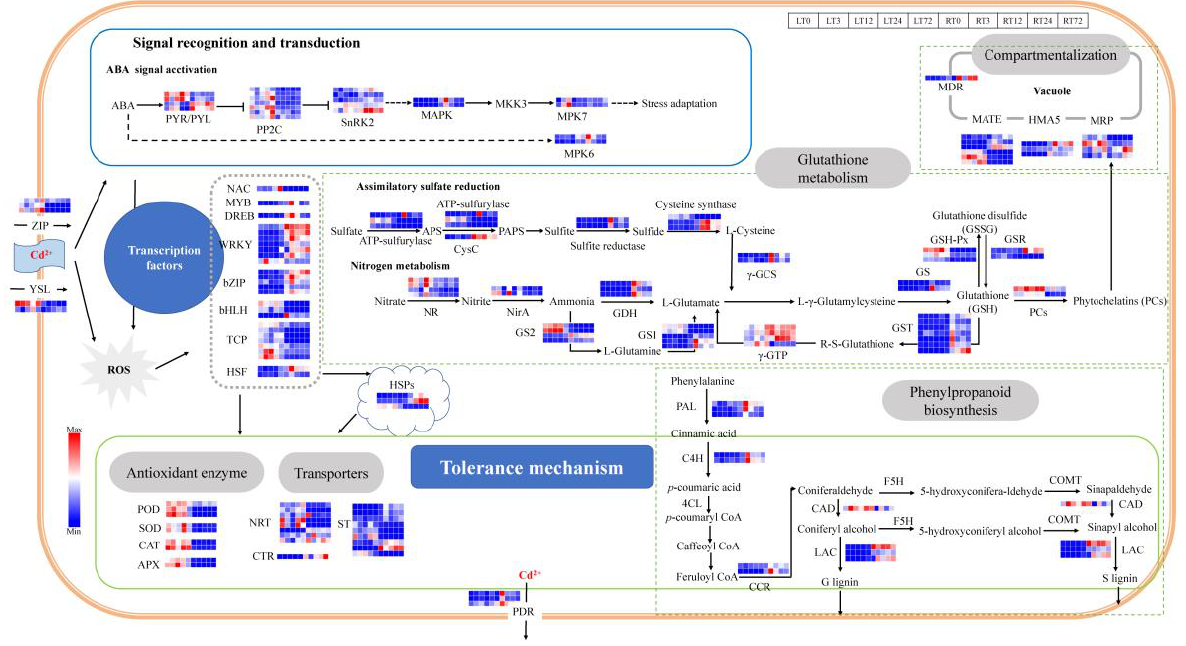
Figure 8. Transcriptional changes of genes responsible for Cd response in leaves and roots of T. repens